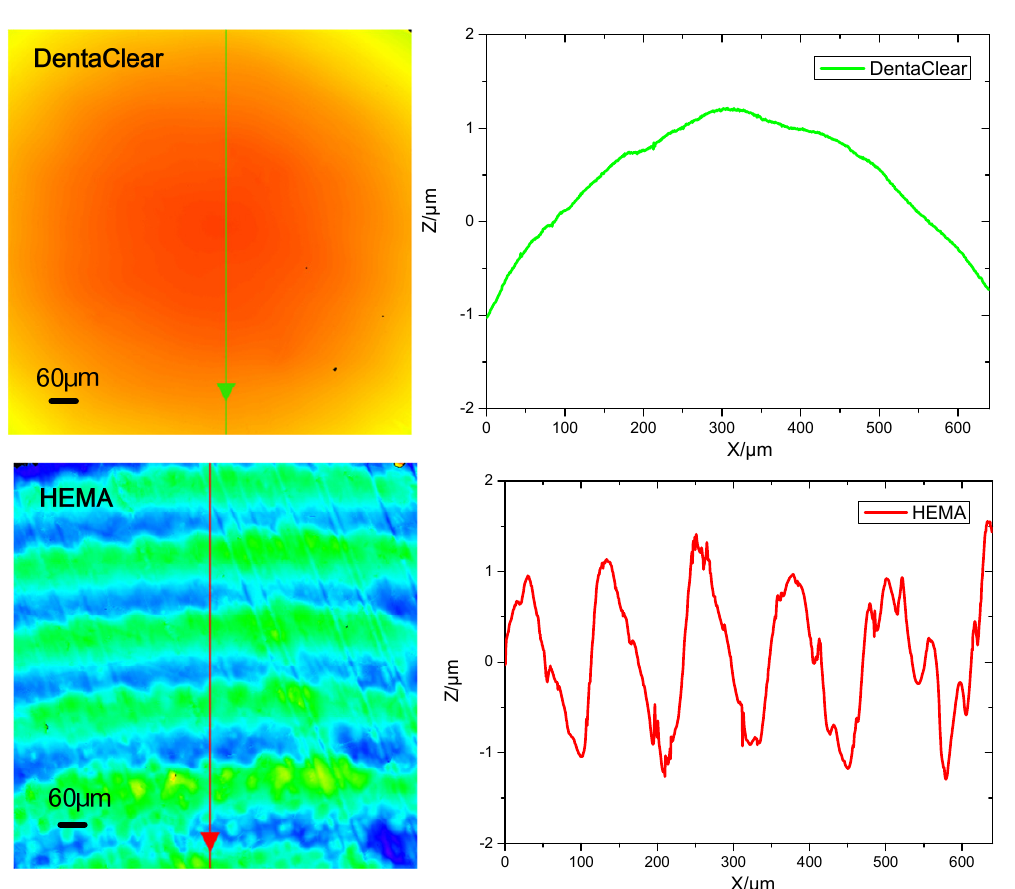
Figure 7. Laser confocal microscope images of the smoothed lens surface and sampling profiles on the surface. The image size is 630 × 630 µ m. Apparent ripples appeared on the HEMA surface even if it was smoothed by post-curing, whilst the surface of DentaClear seemed relatively smooth.